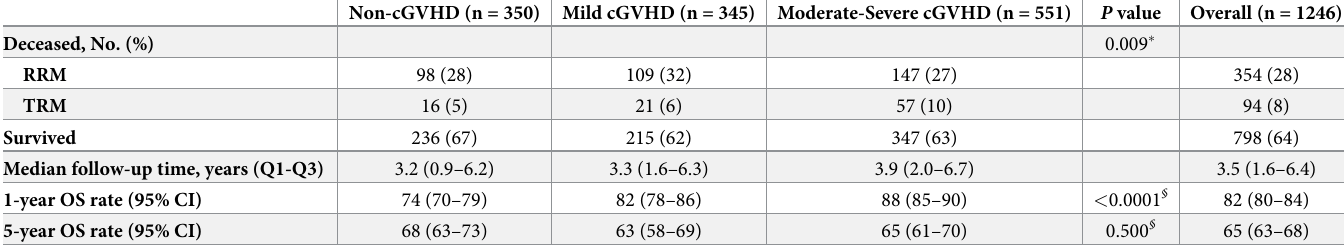
Table 2. Relapse-related mortality, transplant-related mortality, median follow-up time, and 1- and 5-Year OS rates by cGVHD status among patients who survived � 6 months post-HSCT.